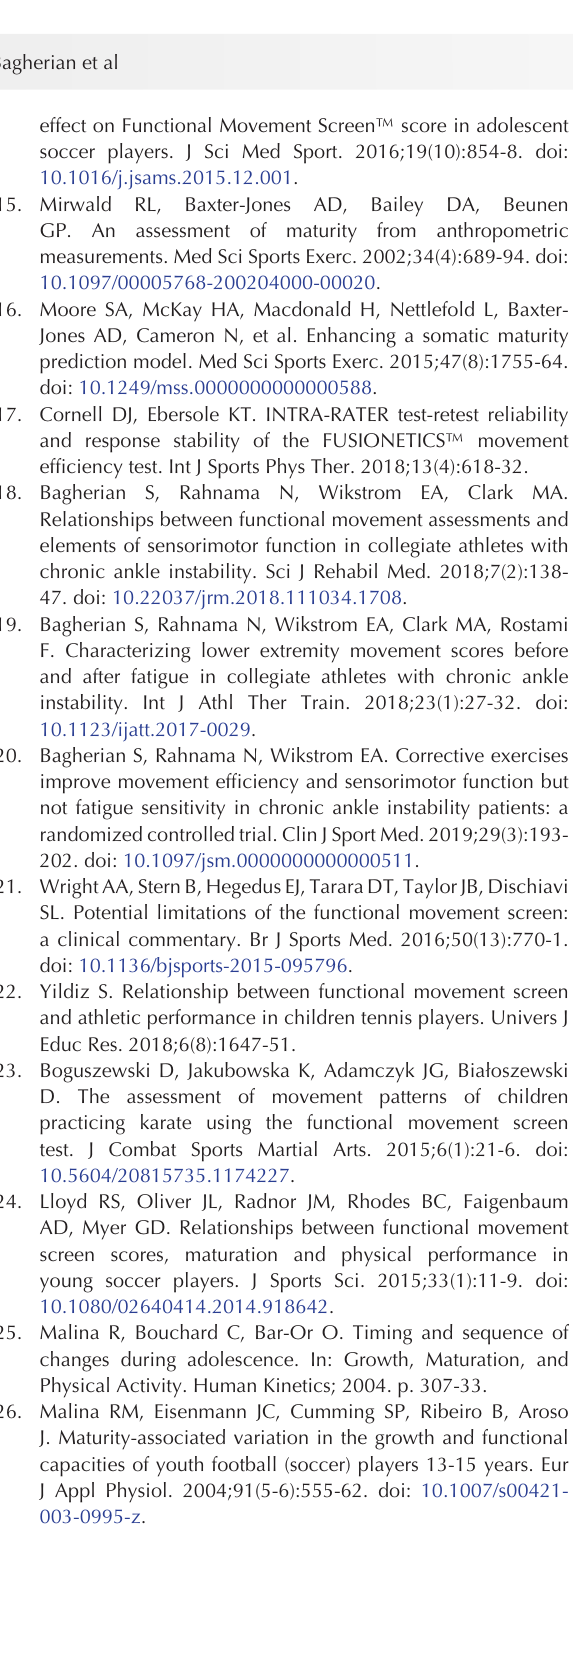
Figueiredo AJ. Biological maturation of youth